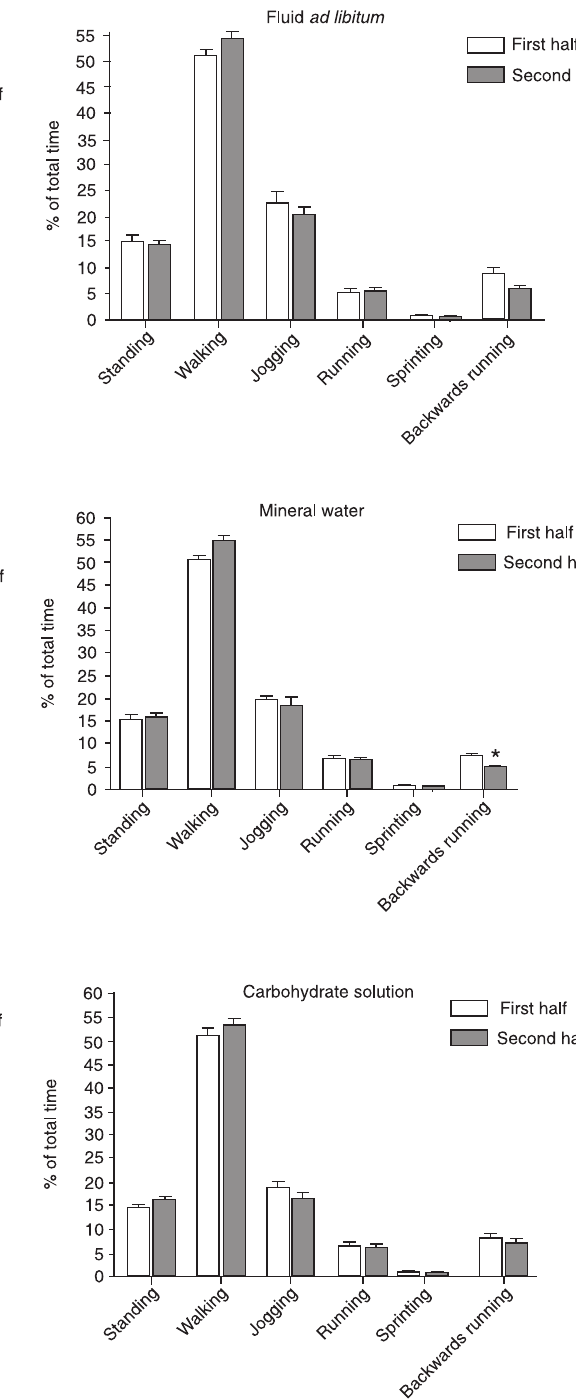
Figure 1. Distances covered by football referees in different lo- comotive categories during the first half (open bars) and second half (filled bars) of a match. Data are reported as means ± SEM in meters. *P < 0.05 for the difference between the first and second halves (two-tailed Student t -test).